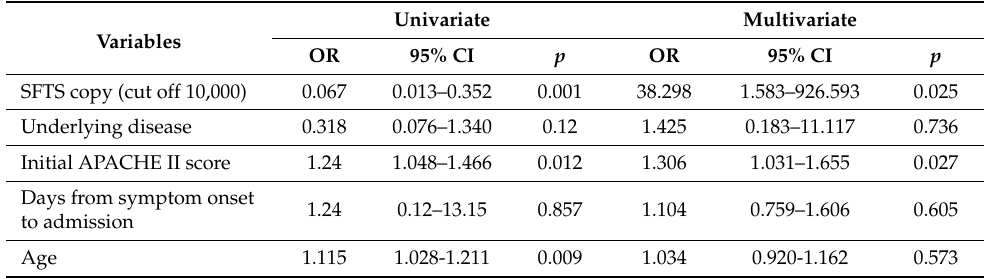
Table 3. Logistic regression analysis between the survival and non-survival